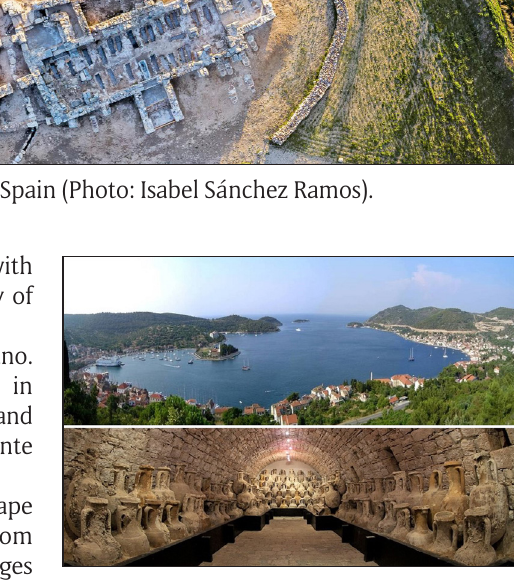
Figure 8: Issa, Greek town on the island of Vis, Croatia, key production site of ampho- rae (Photo: Maja Mise).